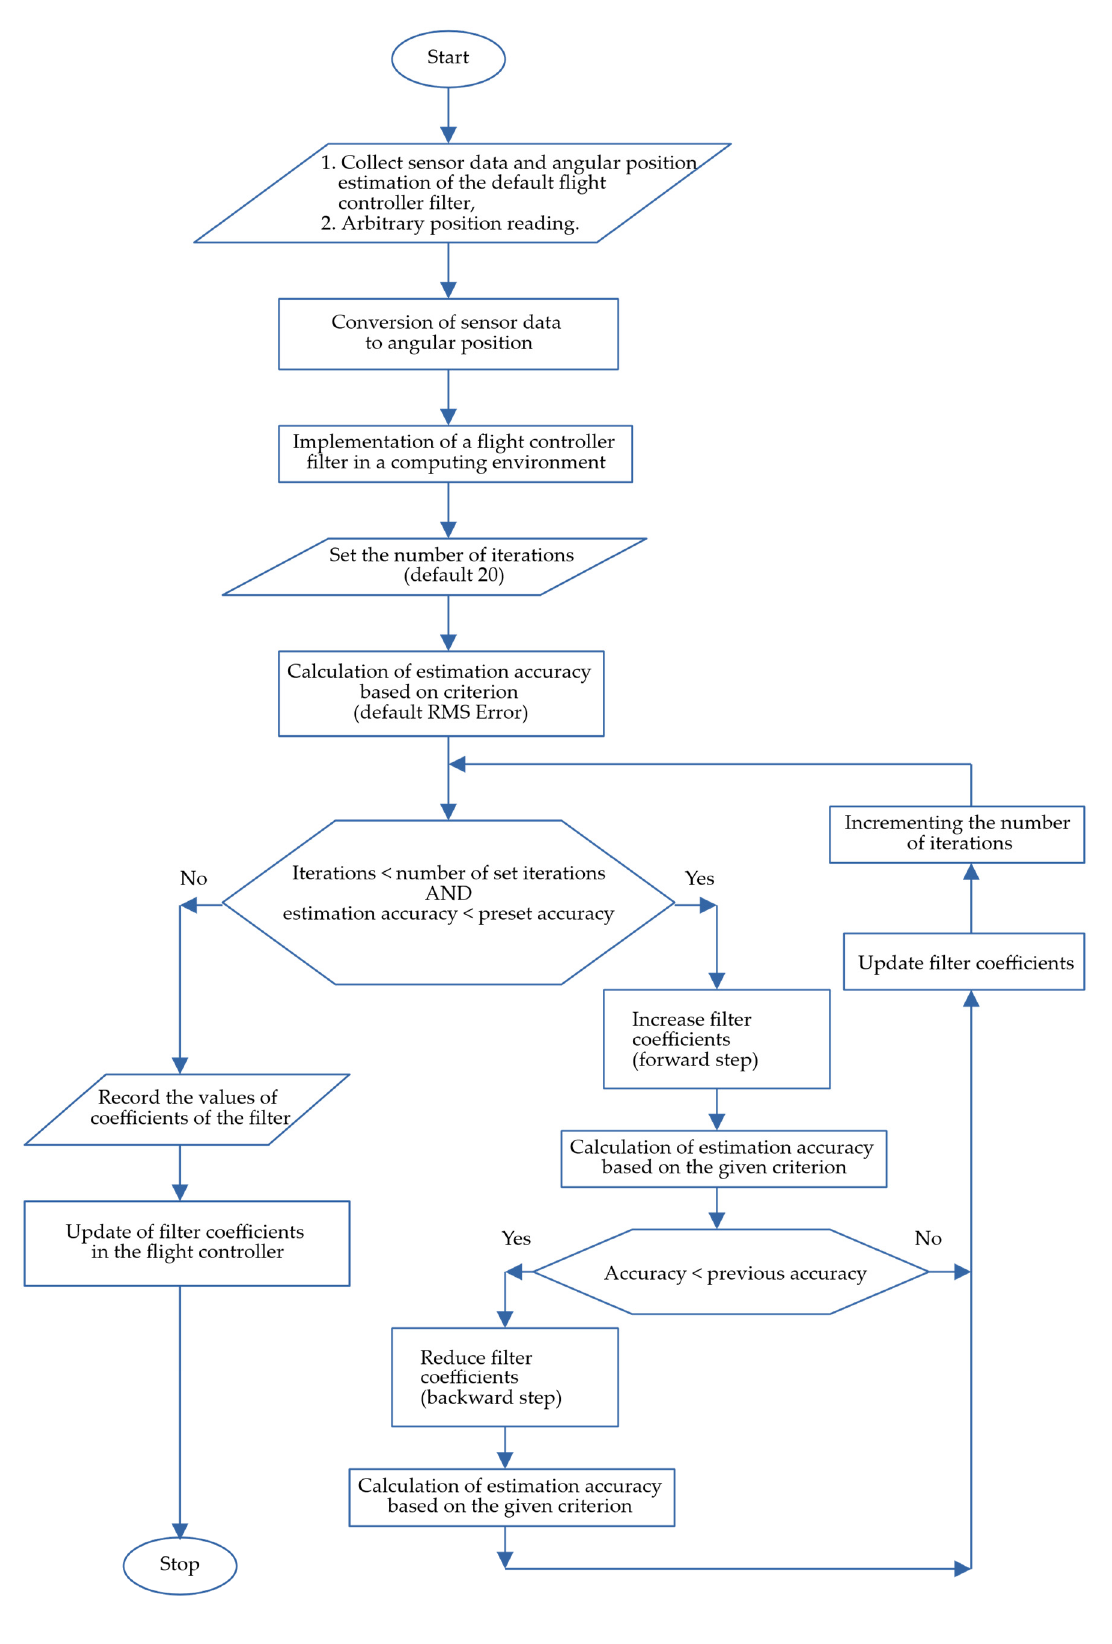
Figure 3. Block diagram of the filter optimization algorithm for a real flight controller.